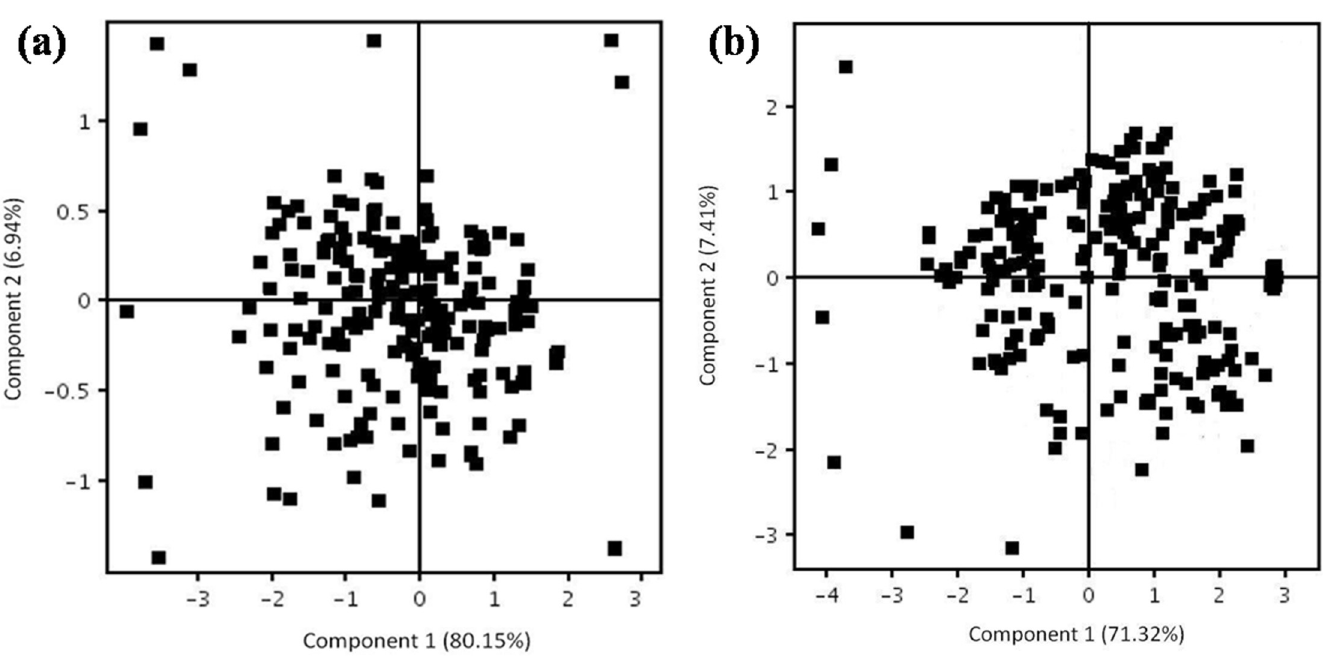
Fig 3. Loading plots (a) in positive ion mode and (b) negative ion mode from PCA model classifying APS and control group.